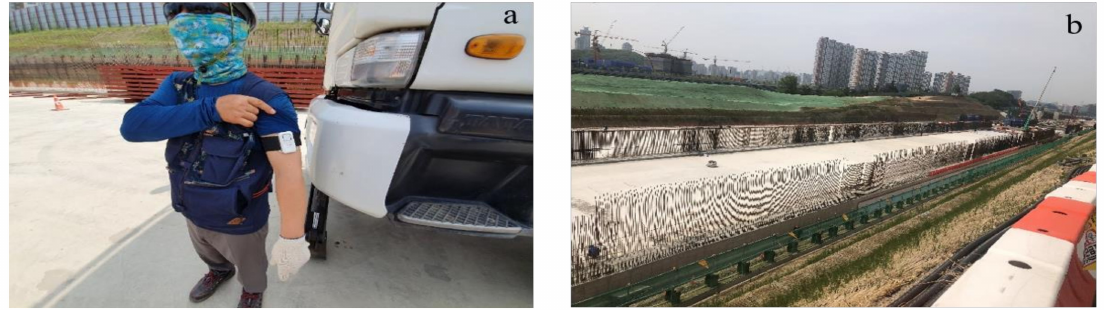
Figure 11. Performance test setup: ( a ) a worker with PWB-300 [55] and the ( b ) Gyeongbu Expressway Straightening Project,